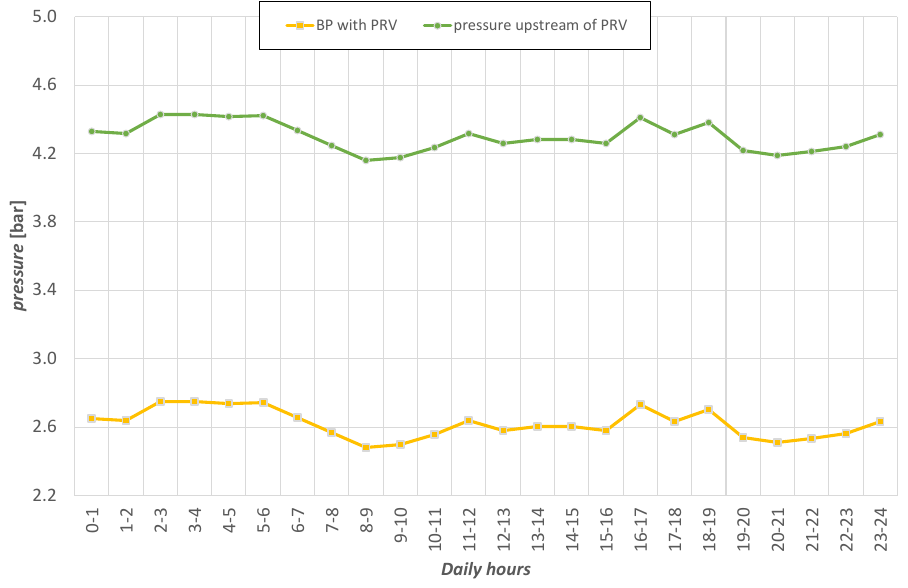
Figure 13. Daily distribution of pressure measured upstream (green line) and downstream (yellow line) of the existing